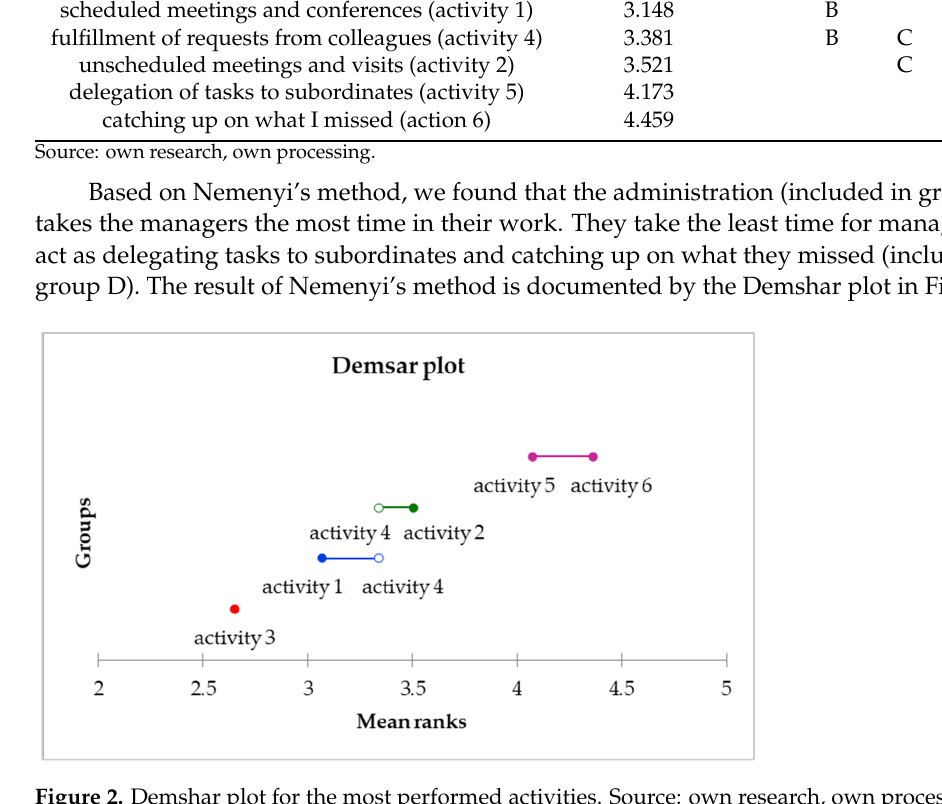
Figure 2. Demshar plot for the most performed activities. Source: own research, own processing.